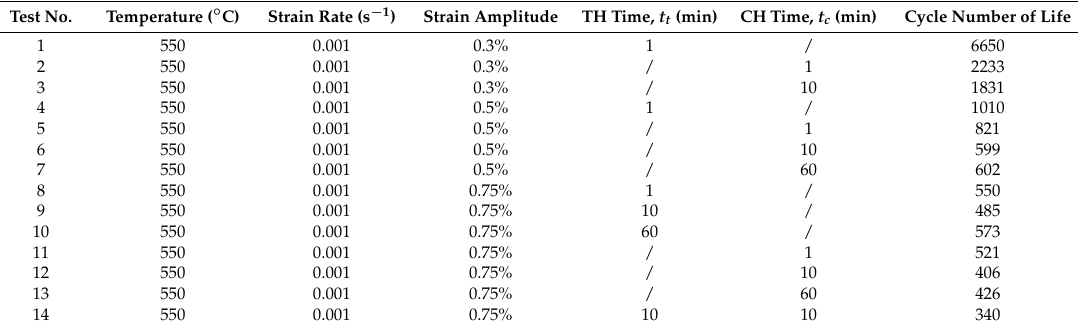
Table 3. CFI test data for P91 steel from [47].